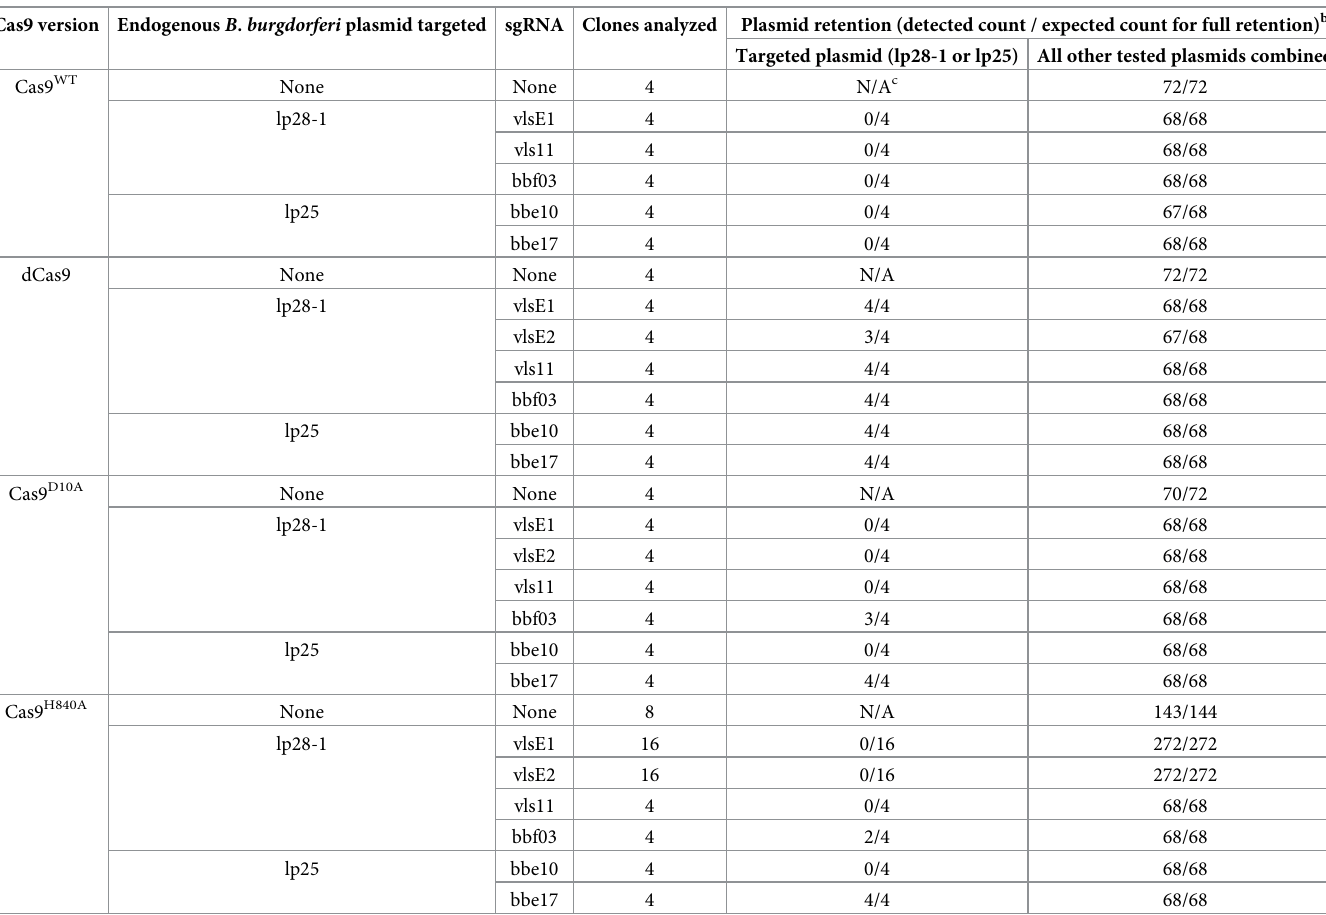
Table 4. Endogenous plasmid retention in individual B . burgdorferi clones after electroporation of Cas9/sgRNA vectors, as detected by multiplex PCR a